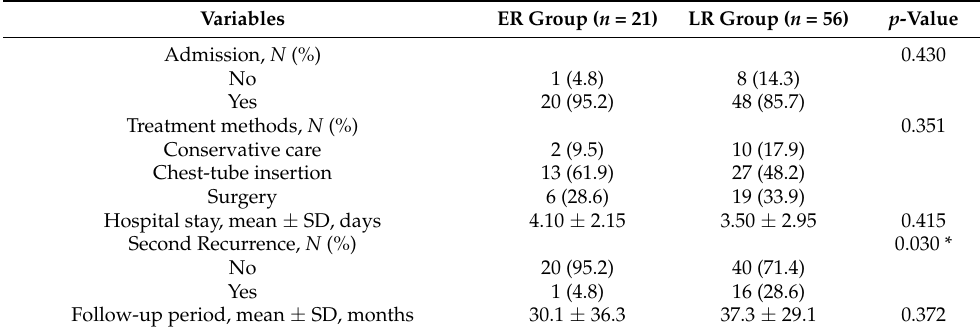
Table 2. Postoperative recurrence (PoR) management between the two groups.